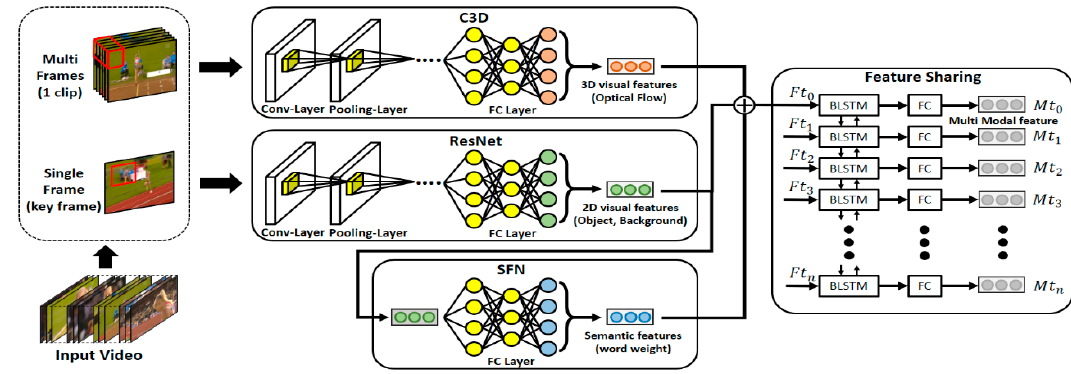
Figure 3. Coarse-level feature learning.